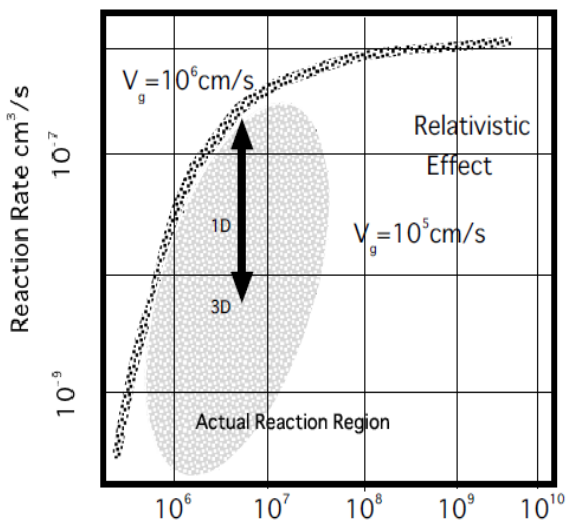
Figure 11. Relative Velocity for Reaction